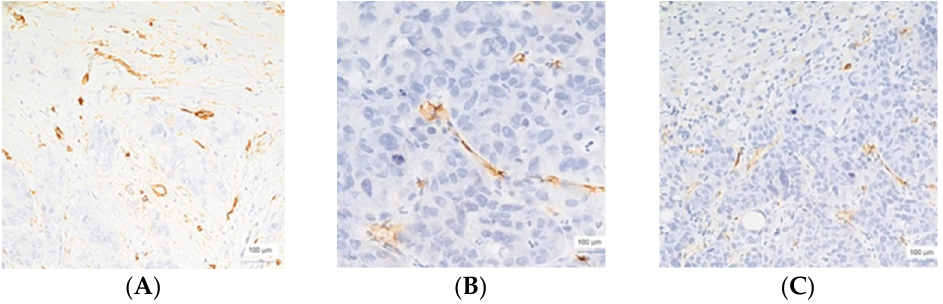
Figure 1. CD 34 immunoexpression, poorly differentiated colon adenocarcinomas, intratumoral vessels, ×200 magnification ( A , B ), and corresponding metastasis (p ‐ HGP), ×200 magnification ( C ).